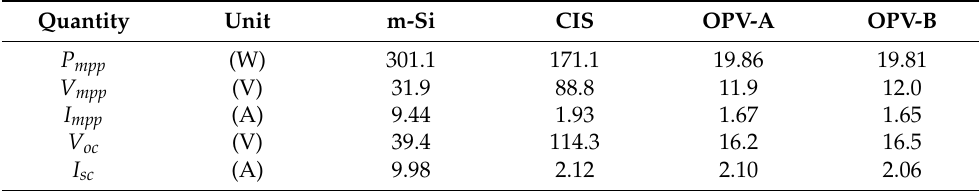
Figure 4. OPV module facing west (OPV ‐ W) installed at the edge of the test facility. The metrics chosen to summarize the energy production of the OPV modules require the definition of a proper time range and the calculation of the global irradiance on the planes of the OPV modules. The setting of the time range for the calculation of the daily production and performance indices was based on the following procedure: 